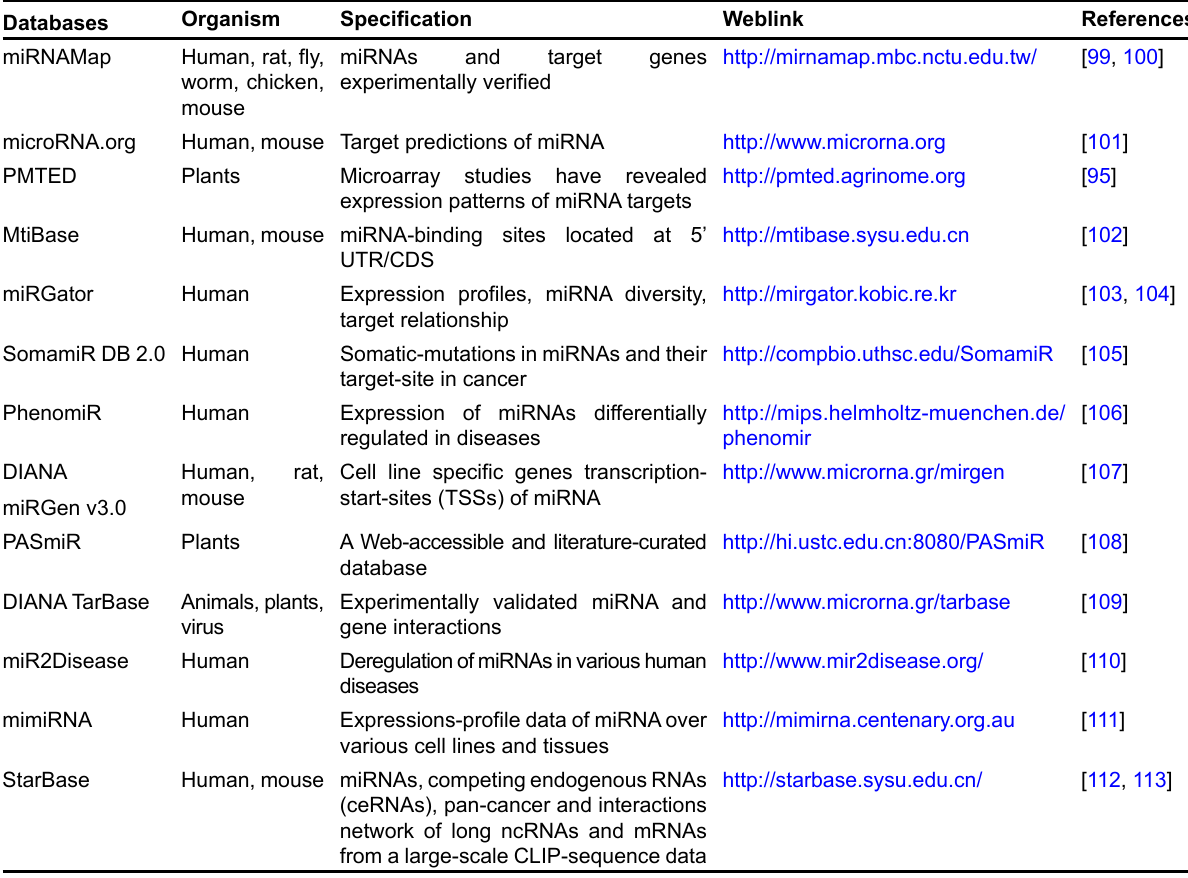
Table 2. A whole repertoire of miRNA